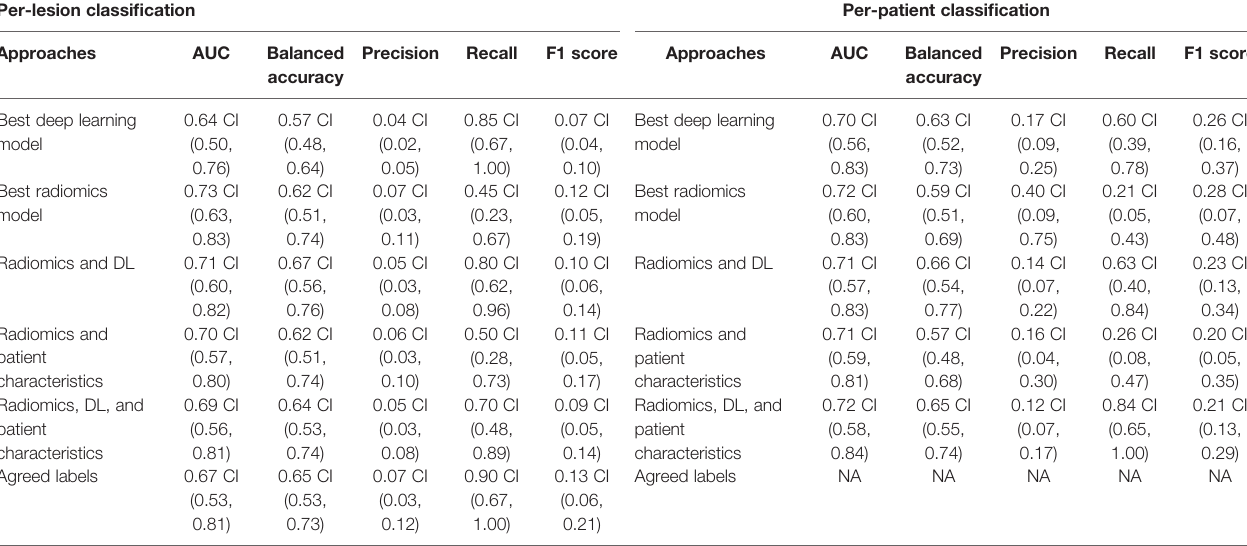
Precision Recall F1 score accuracy